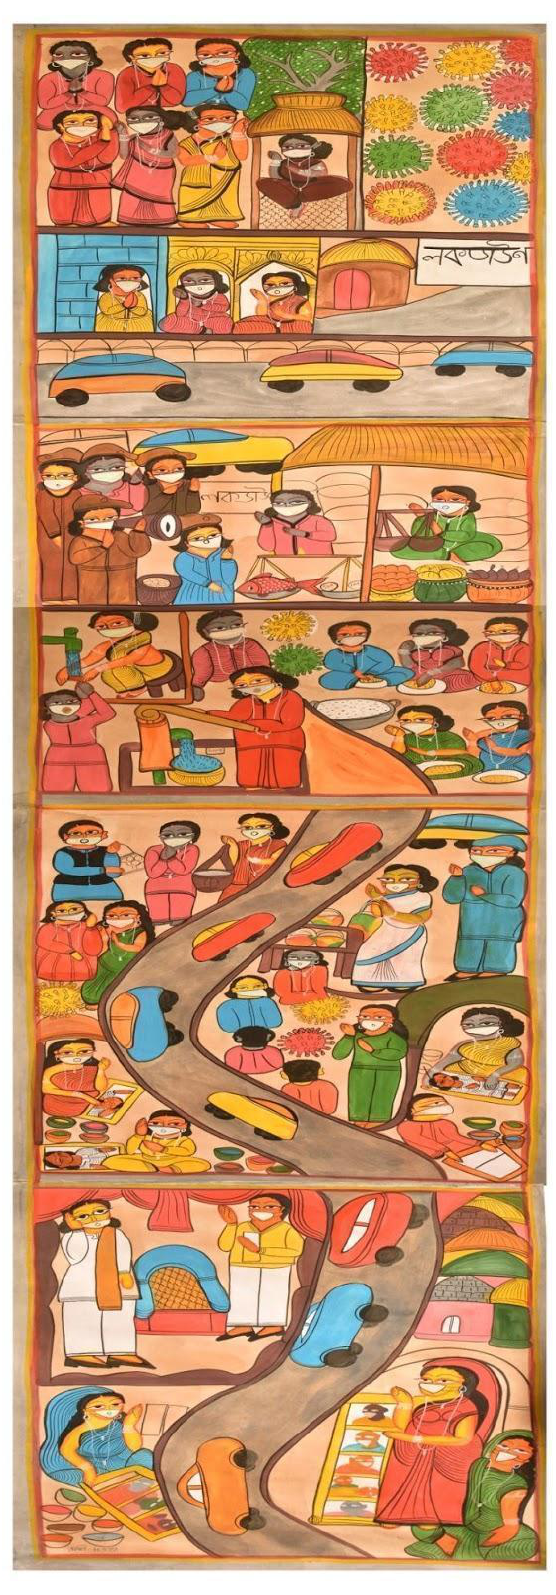
Figure 1. Rani Chitrakar, “Coronavirus”. Commissioned by Anjali Gera Roy for Project “Folk Artists in the Time of Coronavirus”